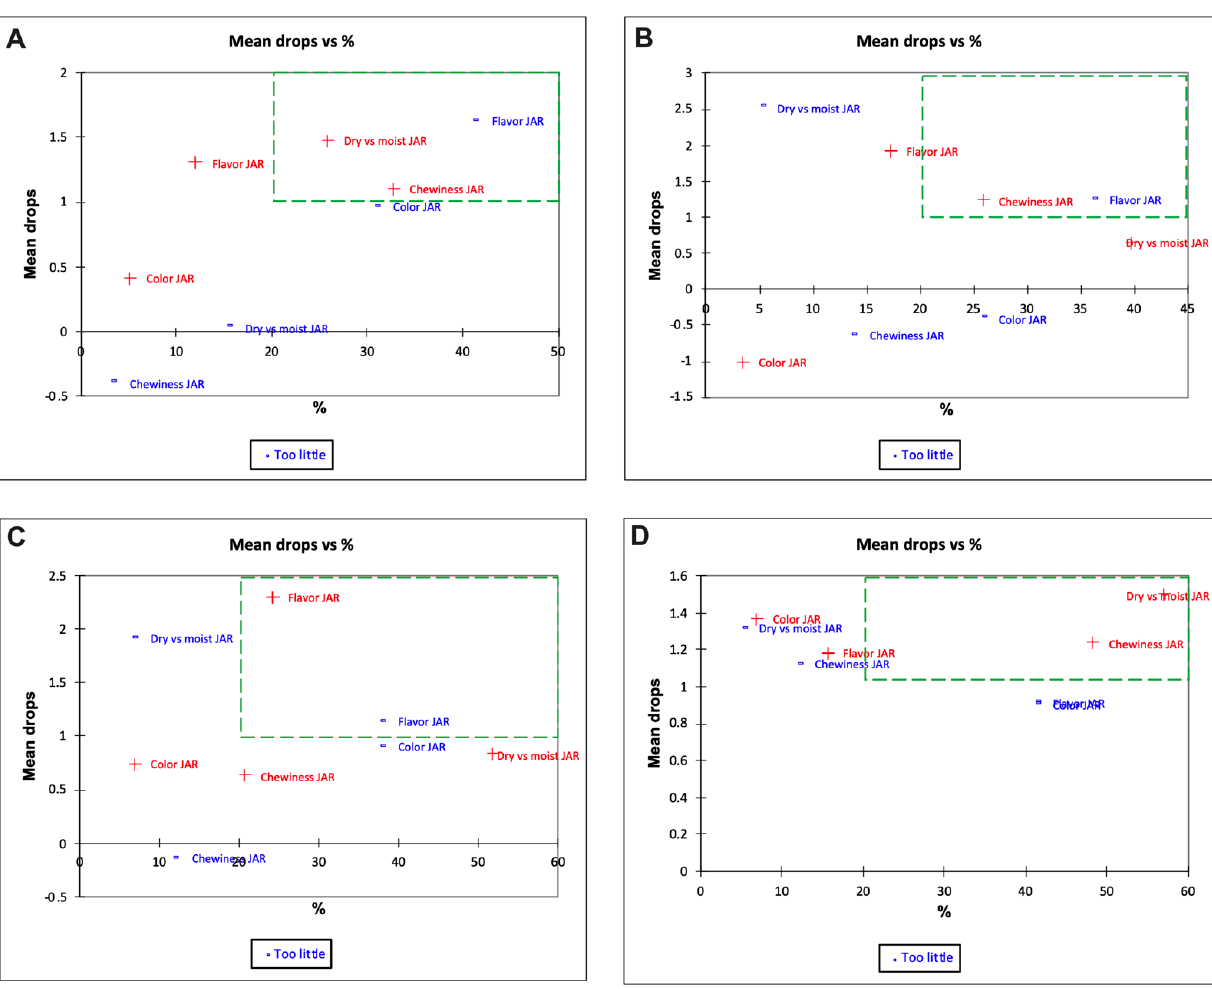
Figure 11. Penalty analysis of day 0 samples (mean drops vs. percent panelist) of Indian flat bread prepared from ( A ) control wheat flour (WF); ( B ) whole wheat flour + encapsulated 17.5 mg iron (EC50); ( C ) whole wheat flour + encapsulated 35 mg iron (EC100); and ( D ) whole wheat flour + color ‐ masked 17.5 mg iron (CM50); n = 58.